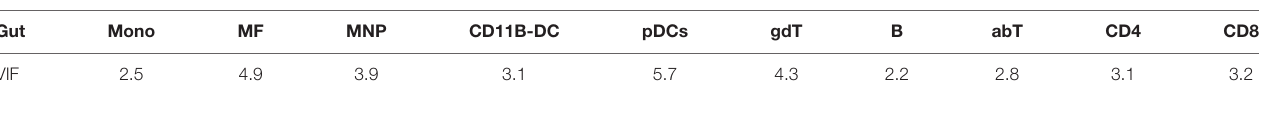
TABLE 2A | Results of VIF analysis in gut.